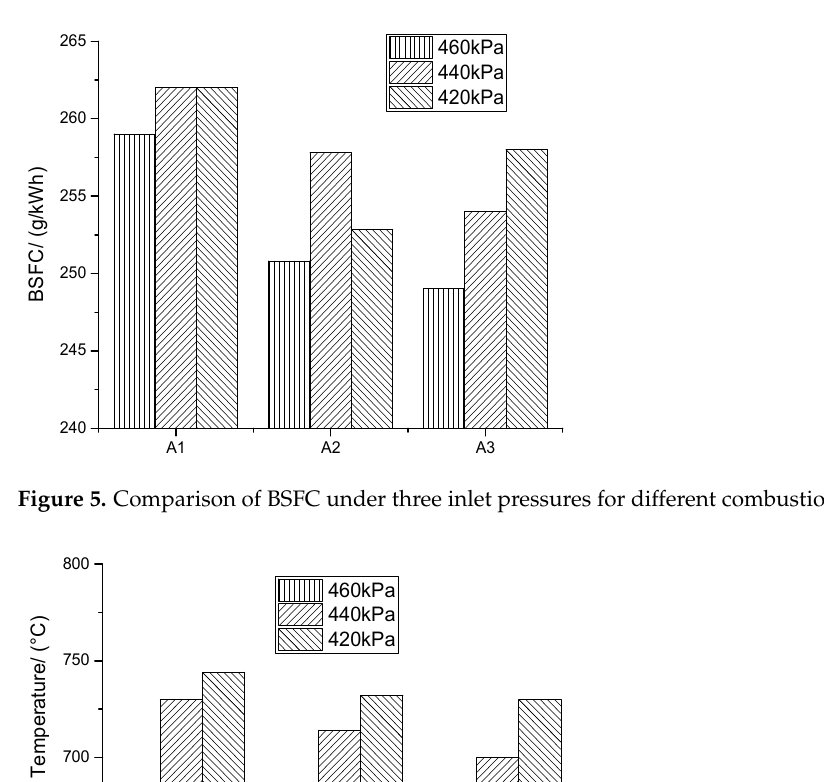
Figure 6. Exhaust temperature for different combustion chambers.